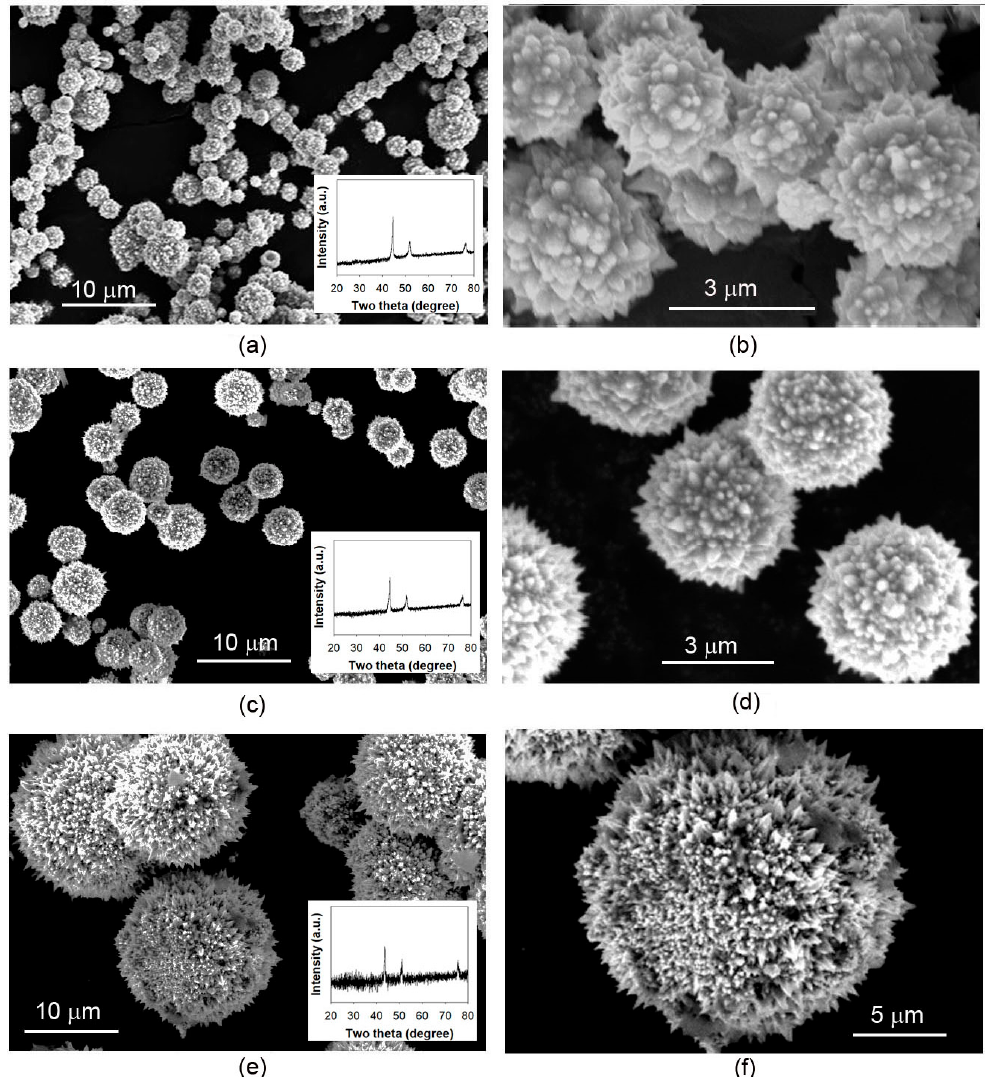
Figure 6. SEM images of the products formed in the presence of 3 mL EDA in 200 mL NaOH solutions of different concentrations for different reaction durations: ( a , b ) 15 M for 1.5 h, ( c , d ) 10 M for 3.5 h, and ( e , f ) 5 M for 5 h. Insets of Figure 6a,c,e are the XRD patterns of the corresponding products.